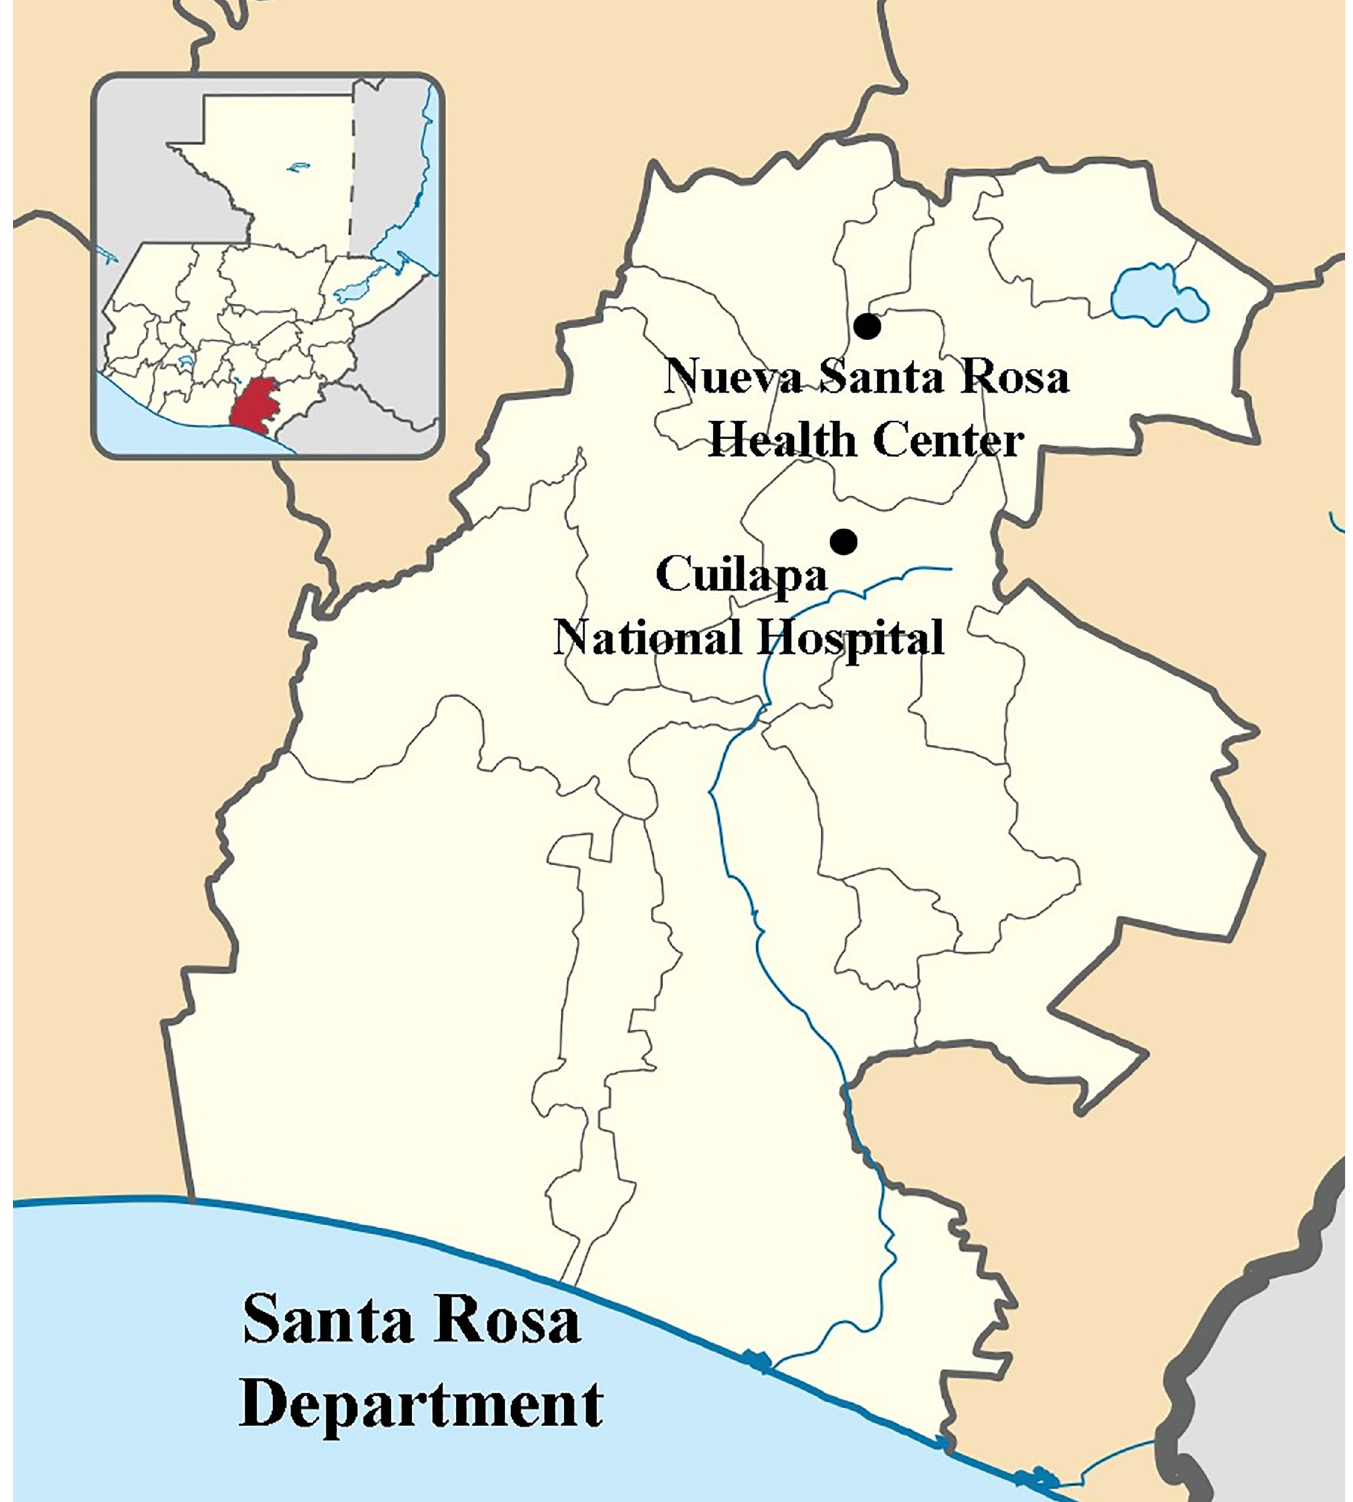
Fig 1. Cuilapa national hospital and nueva Santa Rosa health center, Santa Rosa department, Guatemala. Source: Santa Rosa department location map; by user Edgouno; licensed under CC BY 3.0 via Wikimedia Commons, https://commons.wikimedia.org/wiki/File:Quetzaltenango_department_location_map.svg.